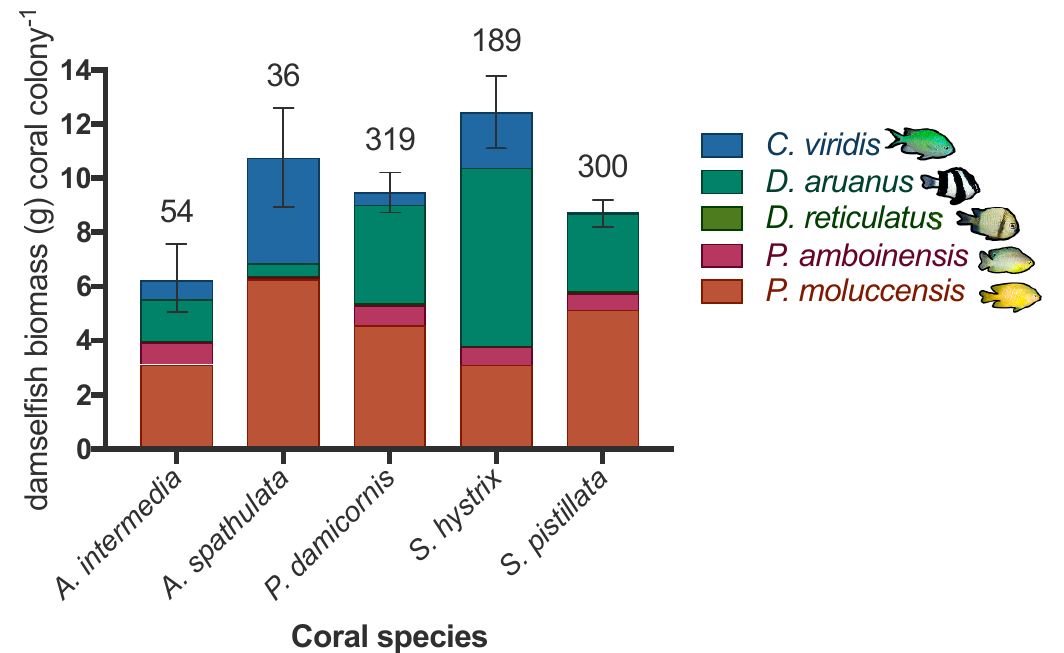
Figure 3. Mean biomass per fish species (g ± standard error (SE) of total biomass of damselfish) per coral species ( Acropora intermedia , Acropora spathulata , Pocillopora damicornis , Seriatopora hystrix , and Stylophora pistillata ) for all occupied colonies ( n = 898) for 5154 fish ( Chromis viridis , Dascyllus aruanus , Dascyllus reticulatus , Pomacentrus amboinensis , and Pomacentrus moluccensis ) at 51 sites. Coral sample sizes per species are displayed above the bars. Note the collapse of Dascyllus reticulatus and Pomacentrus amboinensis sub-bars for the Acropora spathulata coral bar, and again for Dascyllus reticulatus on the Seriatopora hystrix bar, indicating very low biomass values for these fish species on these corals. Further damselfish species-specific and coral species-specific average biomass ( ± SE) per site aspect, and habitat are displayed in Supplementary Tables S3, S4, S5).